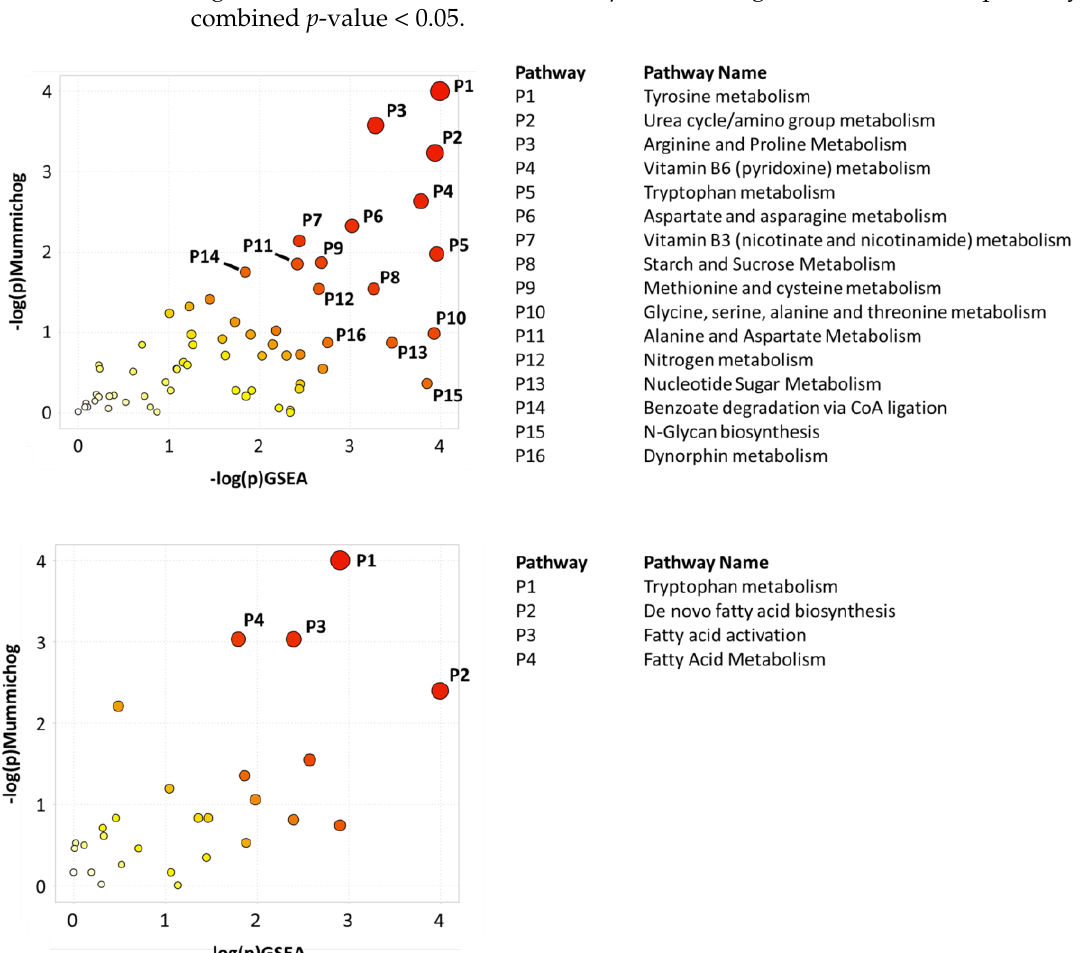
Figure 2. Multivariate analysis of the extracted cell samples. ( A ) PCA of all samples showing sep- aration of different detachment and lysis methods. ( B ) OPLS-DA of all trypsinized samples versus all cell-scraped samples. Sub-splitting can be seen between the bead and freeze – thaw lysis methods, particularly in the trypsinized samples. ( C ) OPLS-DA of all freeze – thawed samples versus all bead- particularly in the freeze – thawed samples.